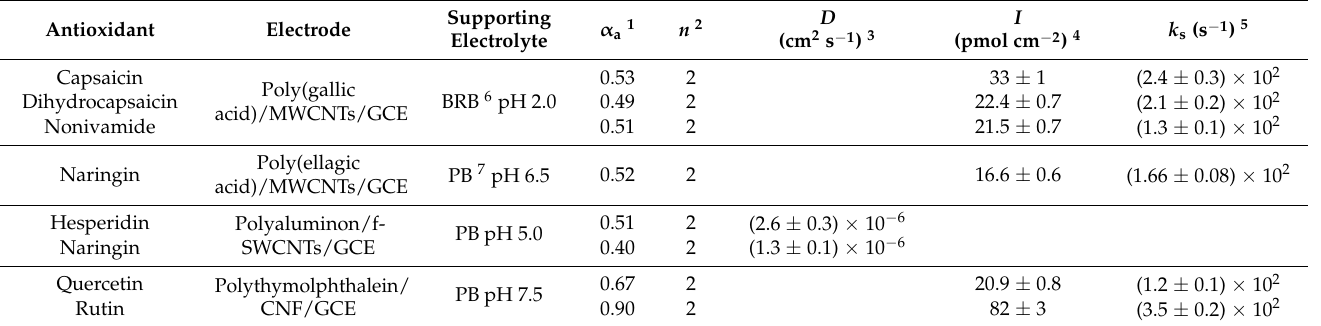
Table 3. Electrooxidation parameters of the capsaicinoids and phenolic antioxidants at the polymer- modified electrodes.